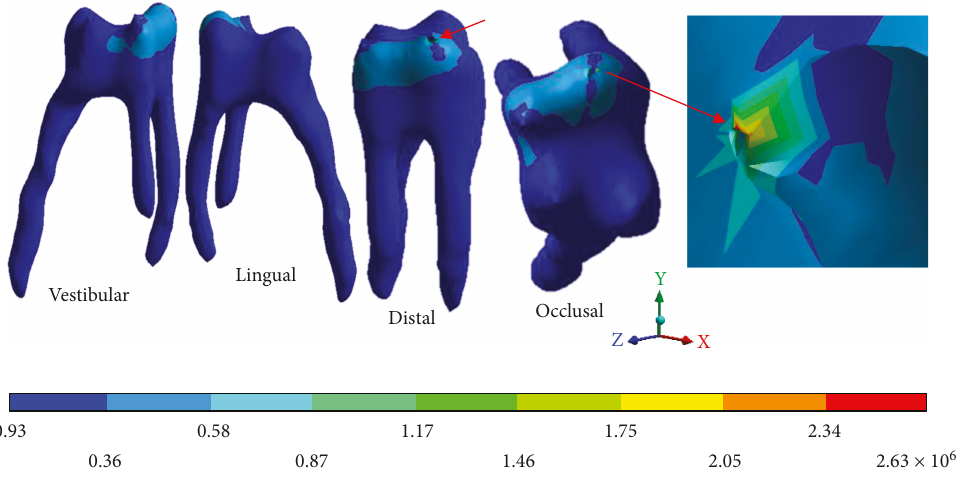
Figure 17: 3rd degree caries : von Mises stresses in